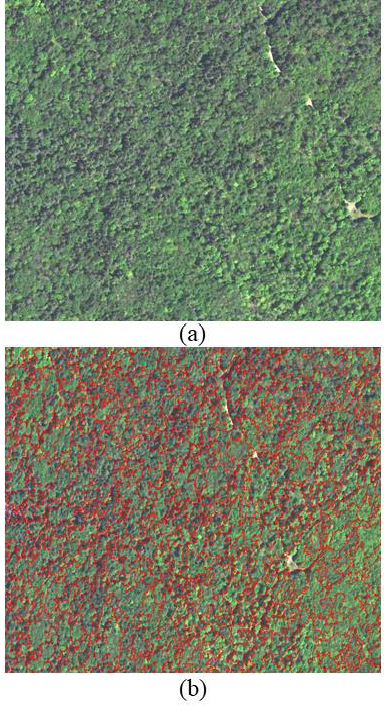
Figure 3 . OBIA using the SNIC segmentation in GEE. (a) Imagery of a zoomed area, (b) boundaries of segmented objects.